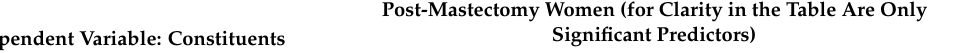
Table 5. The summary of significant stepwise regression models for the ‘body image resilience’ dependent variable in the group of post-mastectomy women ( n = 120); clinical group 1 and clinical group